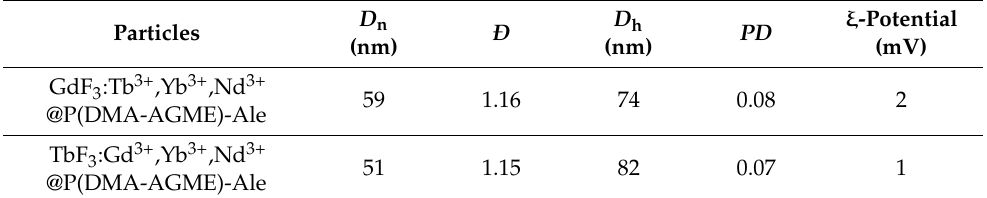
Table 1. Characterization of the nanoparticles.